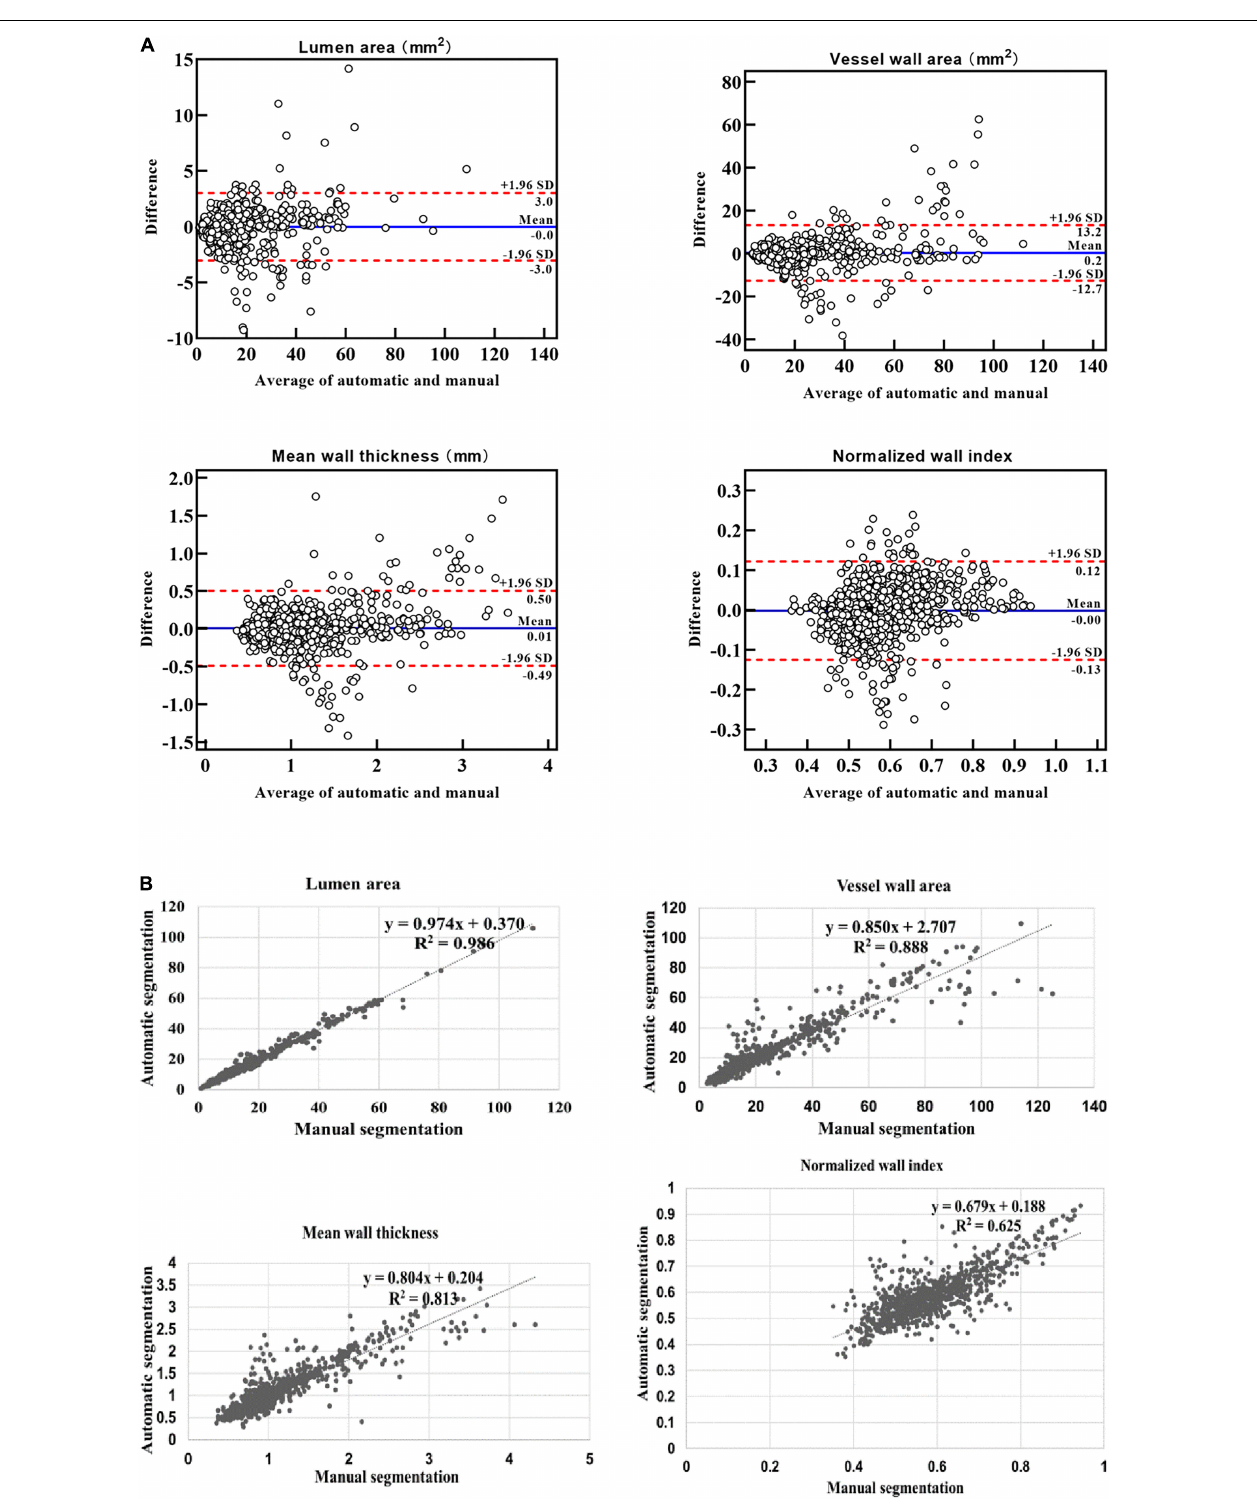
FIGURE 7 | Bland–Altman plots and scatter plots between the automatic method and manual method for the lumen area, wall area, mean wall thickness, and normalized wall index. In panel (A) , the blue lines indicate the mean difference, and the red line represents the 95% CI (computed through average difference ± 1.96 SD of the difference). CI, confidence intervals; SD, standard deviation. In panel (B) , the x -axis shows the manual segmentation value. The y -axis represents the automatic segmentation value.